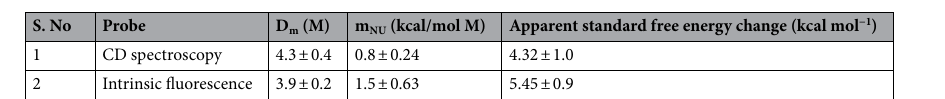
Table 2. Urea-induced equilibrium unfolding parameters of AAR. The values are mean of three measurements along with the standard error of the mean.